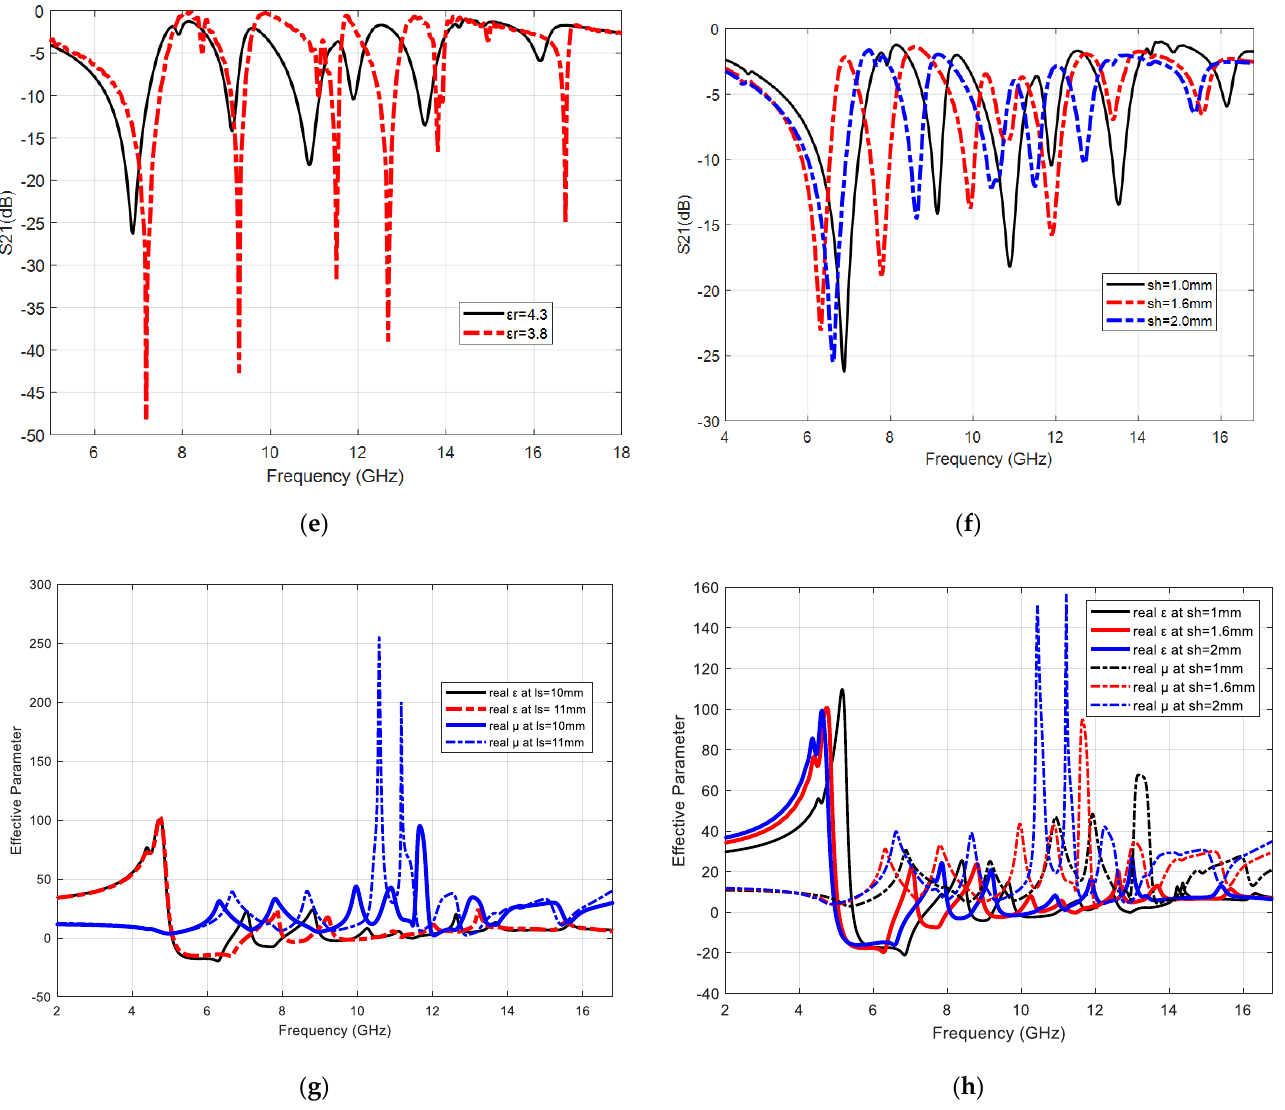
Figure 6. ISMeTM unit cell parameters: ( a ) variation of S11 with g; ( b ) variation of S21 with g; ( c ) variation of S11 with RL; ( d ) variation of S11 with W; ( e ) variation of S21 with dielectric constant of the substrate; ( f ) variation of S21 with sh; ( g ) variation of permittivity and permeability with ls; ( h ) variation of permittivity and permeability with sh.